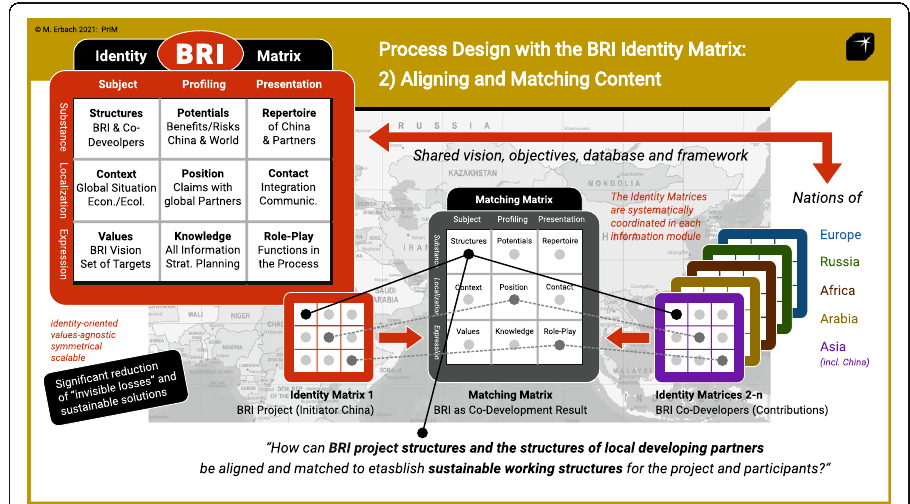
Fig. 8 Aligning and matching content of the BRI Identity Matrix with other